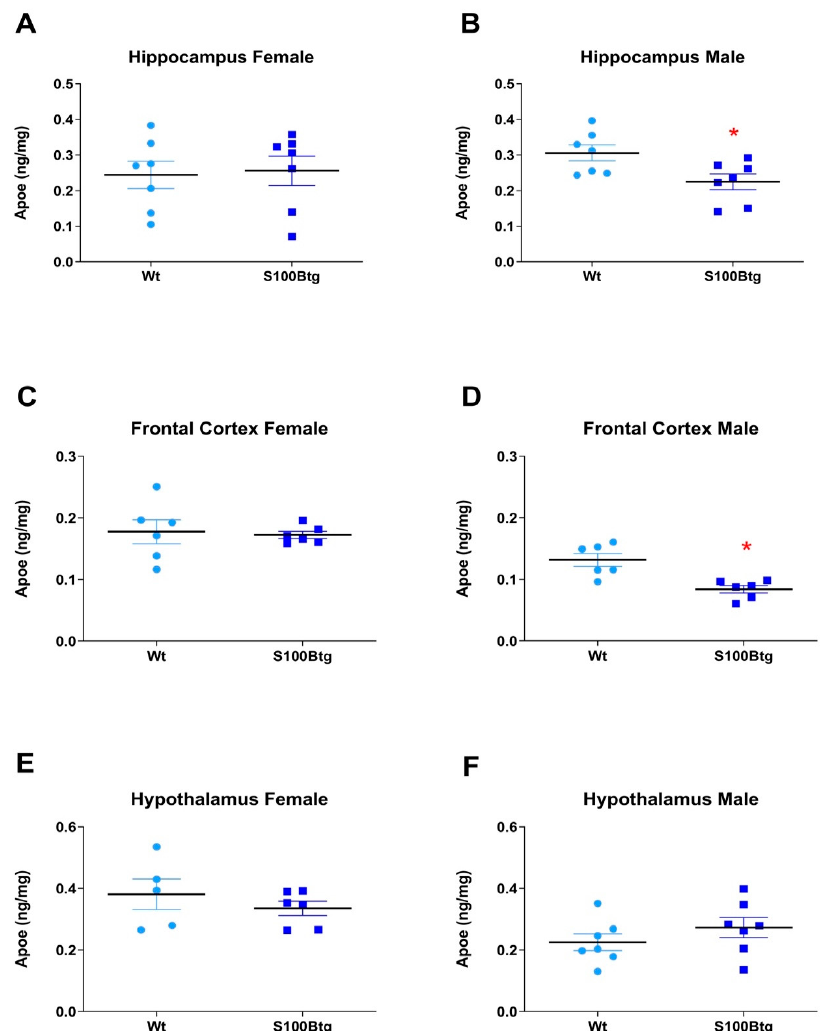
Figure 2. ApoE brain content in one-year-old S100Btg and wt mice. ( A , B ) hippocampus, ( C , D ) frontal cortex, and ( E , F ) hypothalamus; measurements were performed by ELISA. Data are expressed as means ± SE (7 mice/group). * Indicates a statistically significant difference (Student’s t -test, assuming p < 0.05).